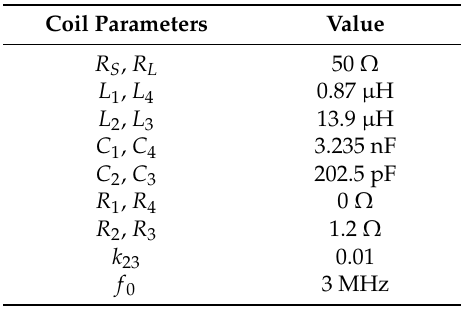
Table 1. Simulated parameters of the proposed four-coil structure.